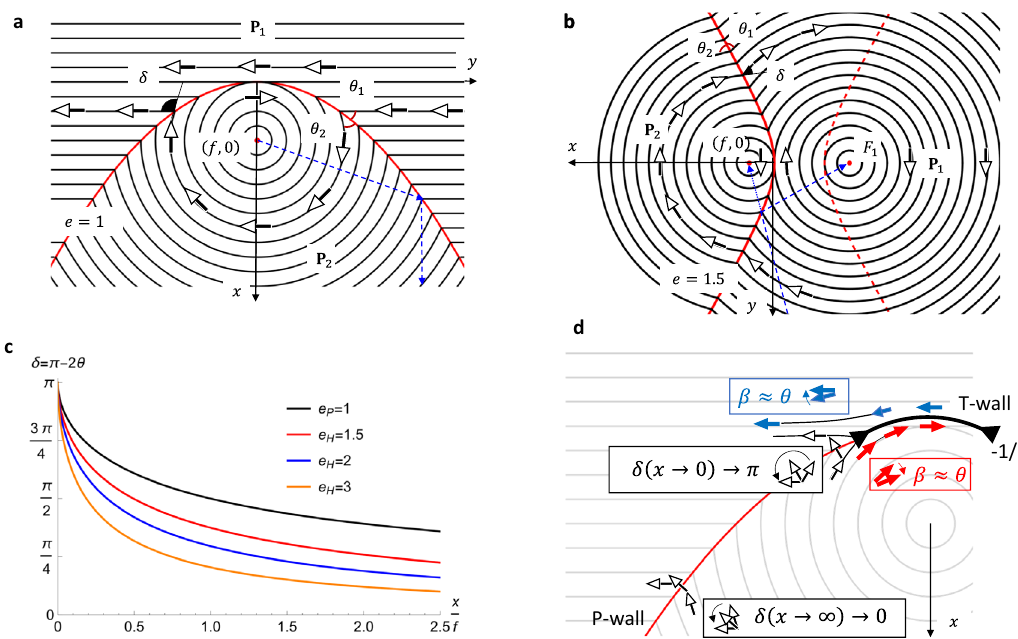
Fig. 4 | Structure of parabolic, hyperbolic, and T-walls. a , b Idealized P- and H- walls, respectively; the dashed blue lines illustrate re fl ection and bisecting prop- erties, θ 1 = θ 2 . c the angle δ = π -2 θ between P 1 and P 2 at the wall vs. x/f , calculated using Eqs. (2) and (3); δ → 0 for x → ∞ and δ → π for x → 0. d At the tip of the P- and H- walls, high elastic bend energy is relieved by two − 1/2 disclinations and a T-wall